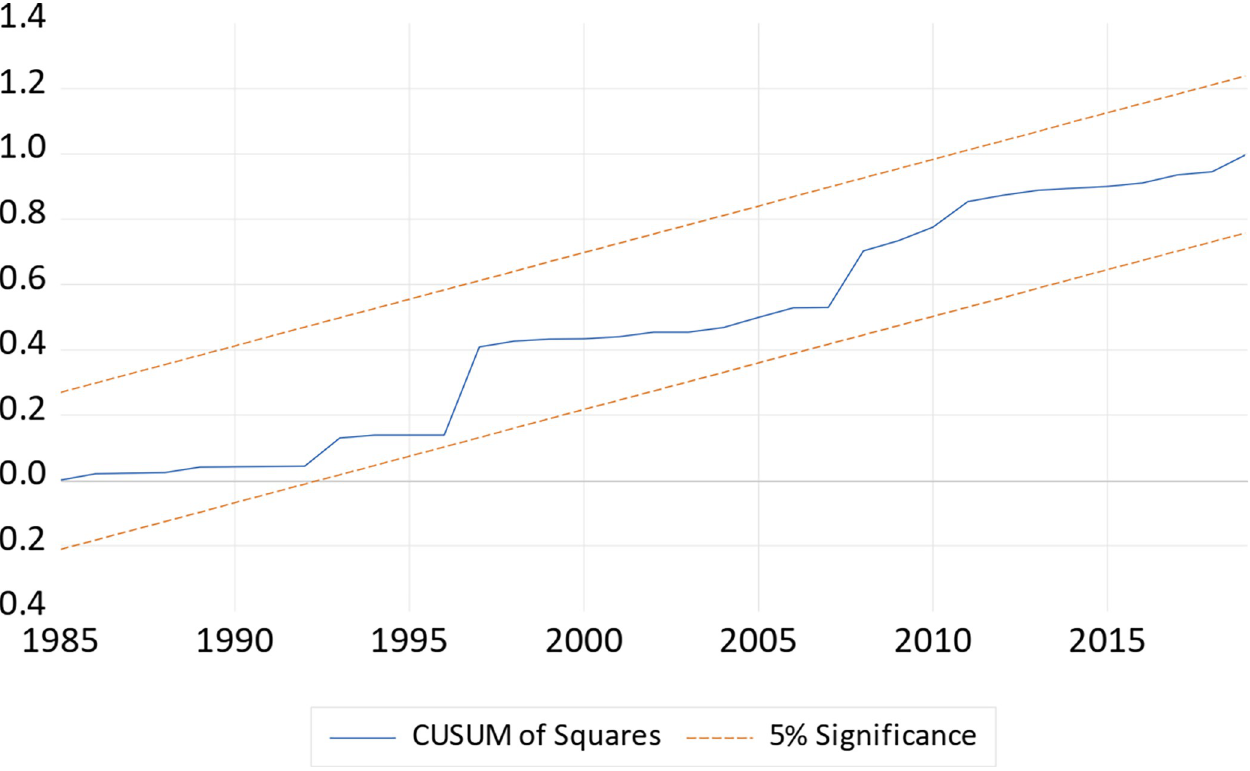
Fig 2. Plot of cumulative sum of squares of recursive